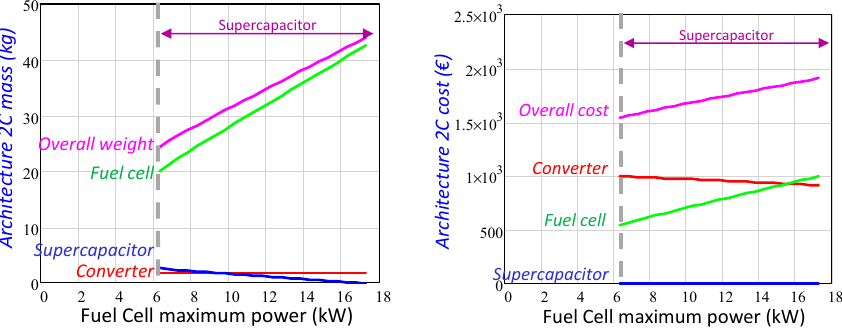
Figure 19. Architecture 1C2 mass and cost.